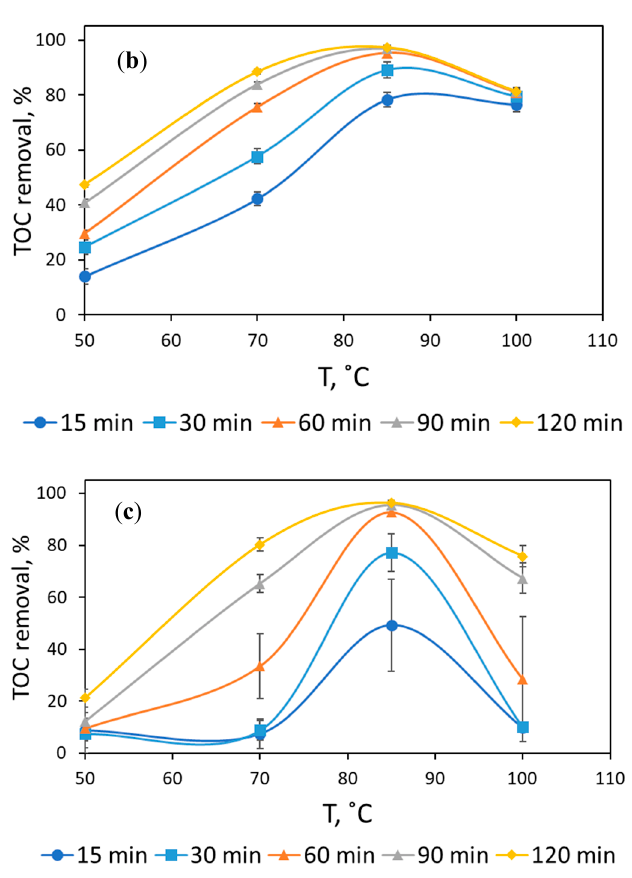
Figure 2. TOC removal at different reaction times depending on the temperature, adding ( a ) 100 mM NaNO 2 , ( b ) 50 mM NaNO 2 and ( c ) 0 mM NaNO 2 , and using 1.72 M HNO 3 .